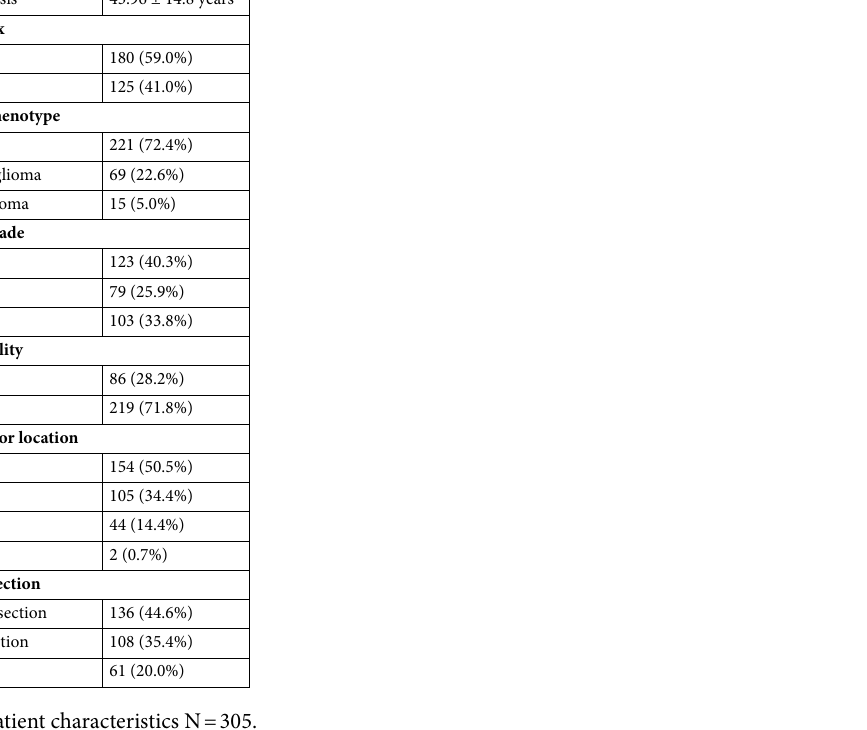
Table 1. Patient characteristics N =